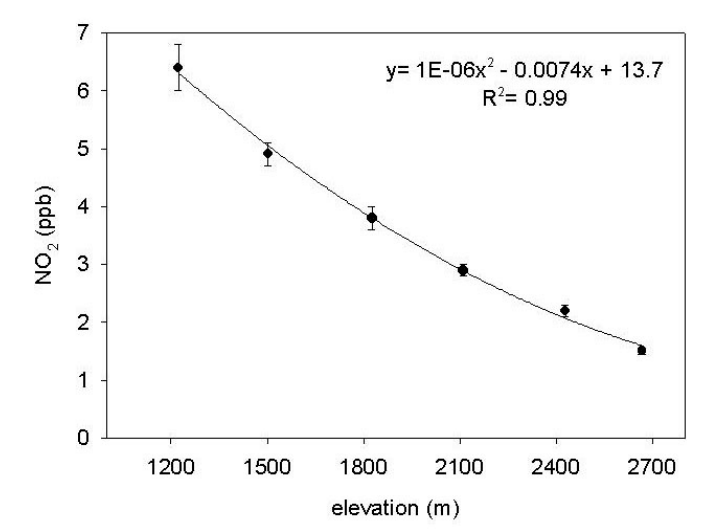
FIGURE 6. Changes of seasonal means of NO 2 (ppb) along the elevation gradient in the San Bernardino Mountains. Means ± SE.